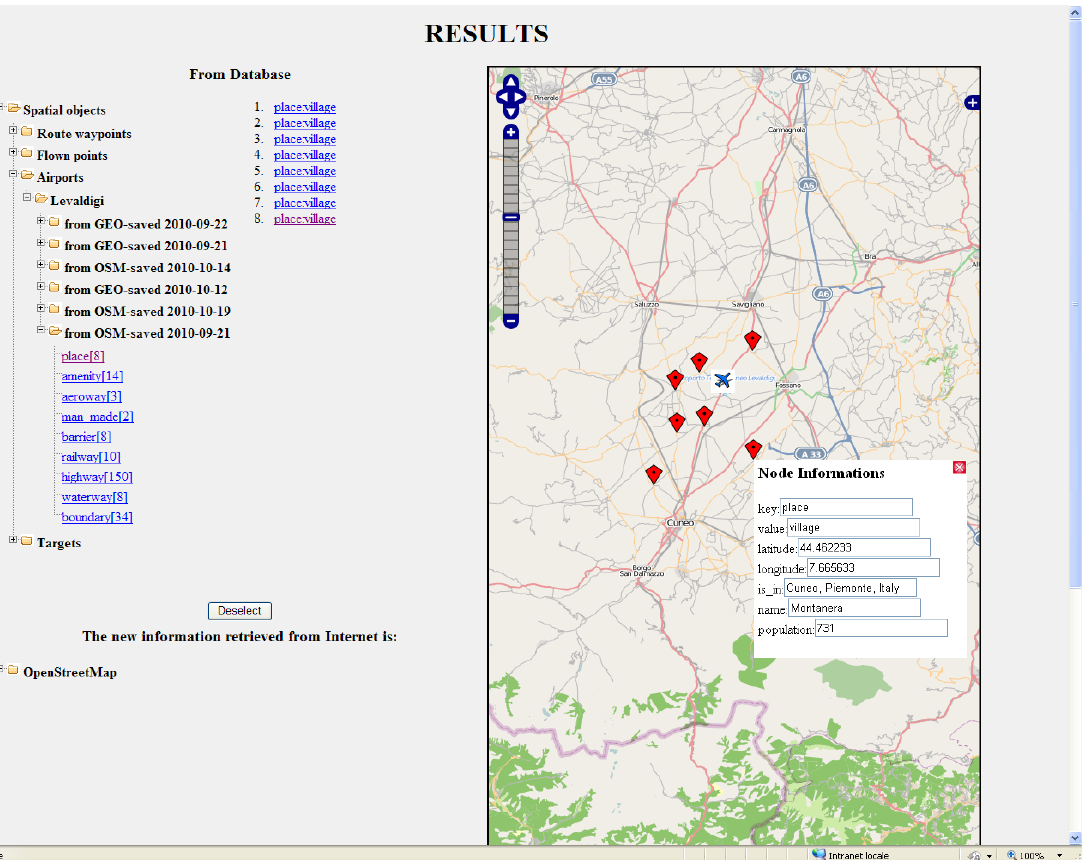
Figure 13. SMAT-F1 Interactive map with